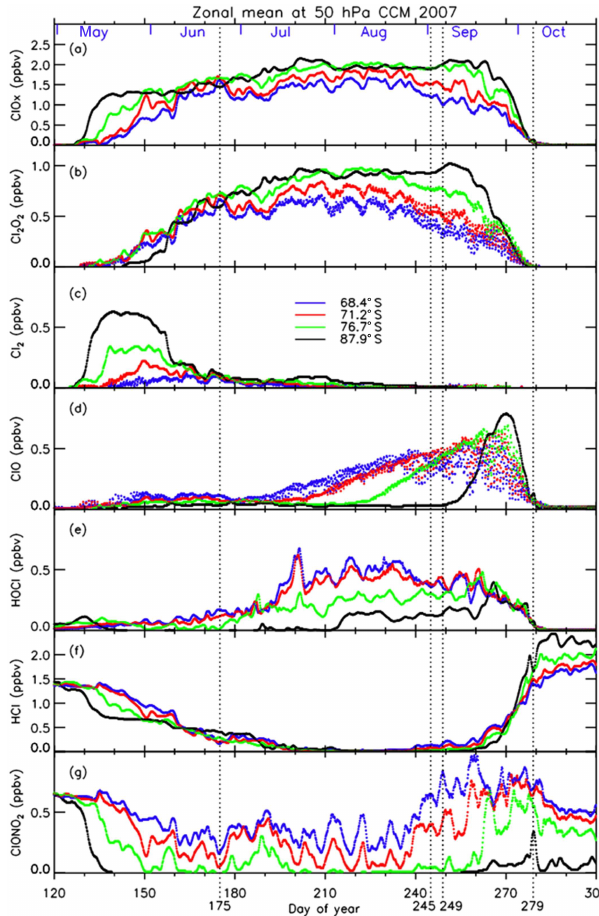
Figure 15. Three-hourly zonal-mean time series of MIROC3.2 CCM outputs for (a) ClO + 2 · Cl 2 O 2 + 2 · Cl 2 , (b) Cl 2 O 2 , (c) Cl 2 , (d) ClO, (e) HOCl, (f) HCl, and (g) ClONO 2 during day number 120–300 at 50hPa in